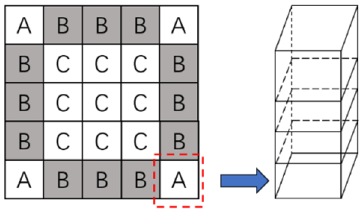
Figure 1. The silicon ingot divided into zones A, B, and C corresponding to the corner, edge, and center, respectively.